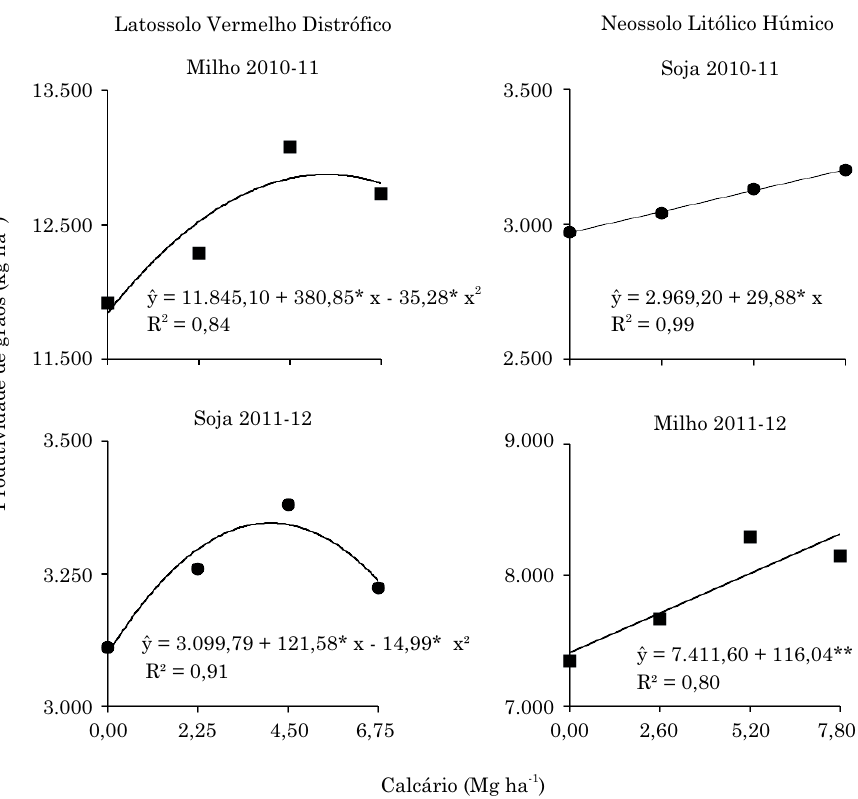
Figura 6. Produtividade de grãos de milho (■) e soja (●) no LatossoloVermelho Distrófico e de soja (●) e milho (■) no Neossolo Litólico Húmico, respectivamente em 2010/11 e 2011/12, considerando as doses de calcário na superfície no sistema plantio direto. os valores são médias de duas fontes de calcário (dolomítico e calcítico) e duas faixas de prnt (B e d). A calagem foi realizada em agosto de 2010. * e **: significativo a 5 e 1 %,